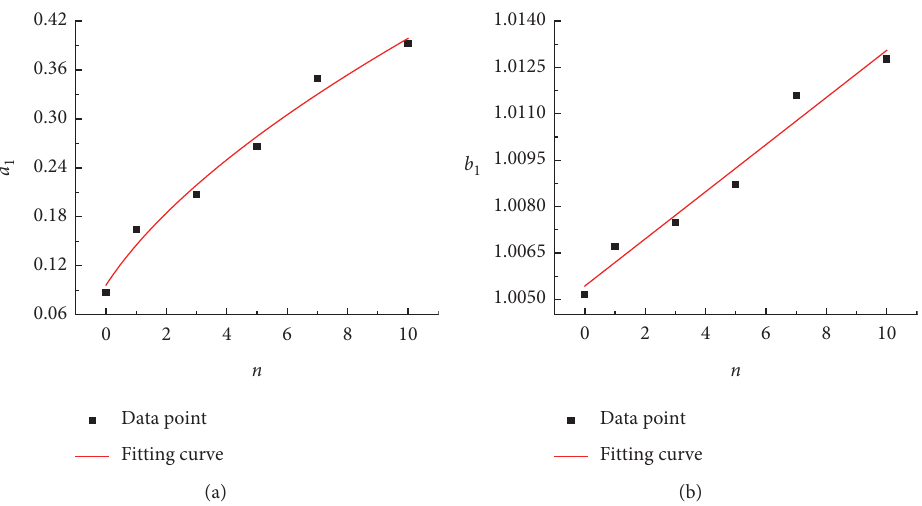
Figure 8: Relationship curves between parameters of a 1 and b 1 and numbers of dry-wet cycle. (a) a 1 and (b) b 1 .